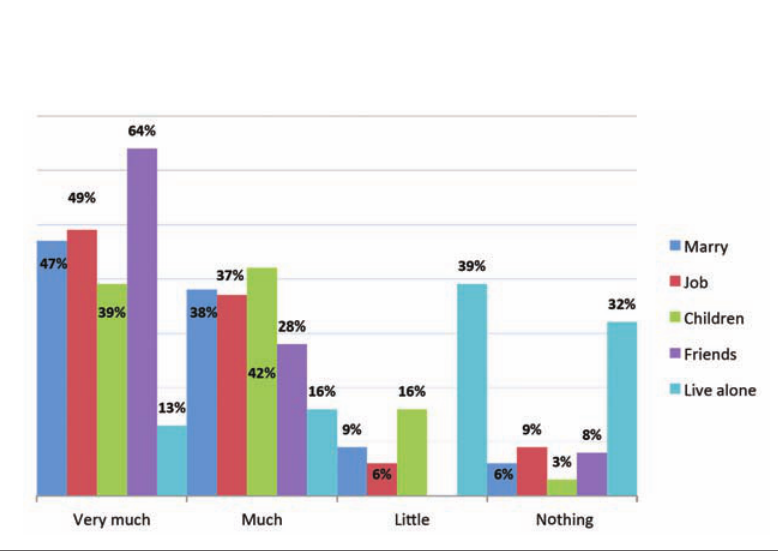
Figure 5. Importance of: being married; finding a job; having children; having friends; living alone